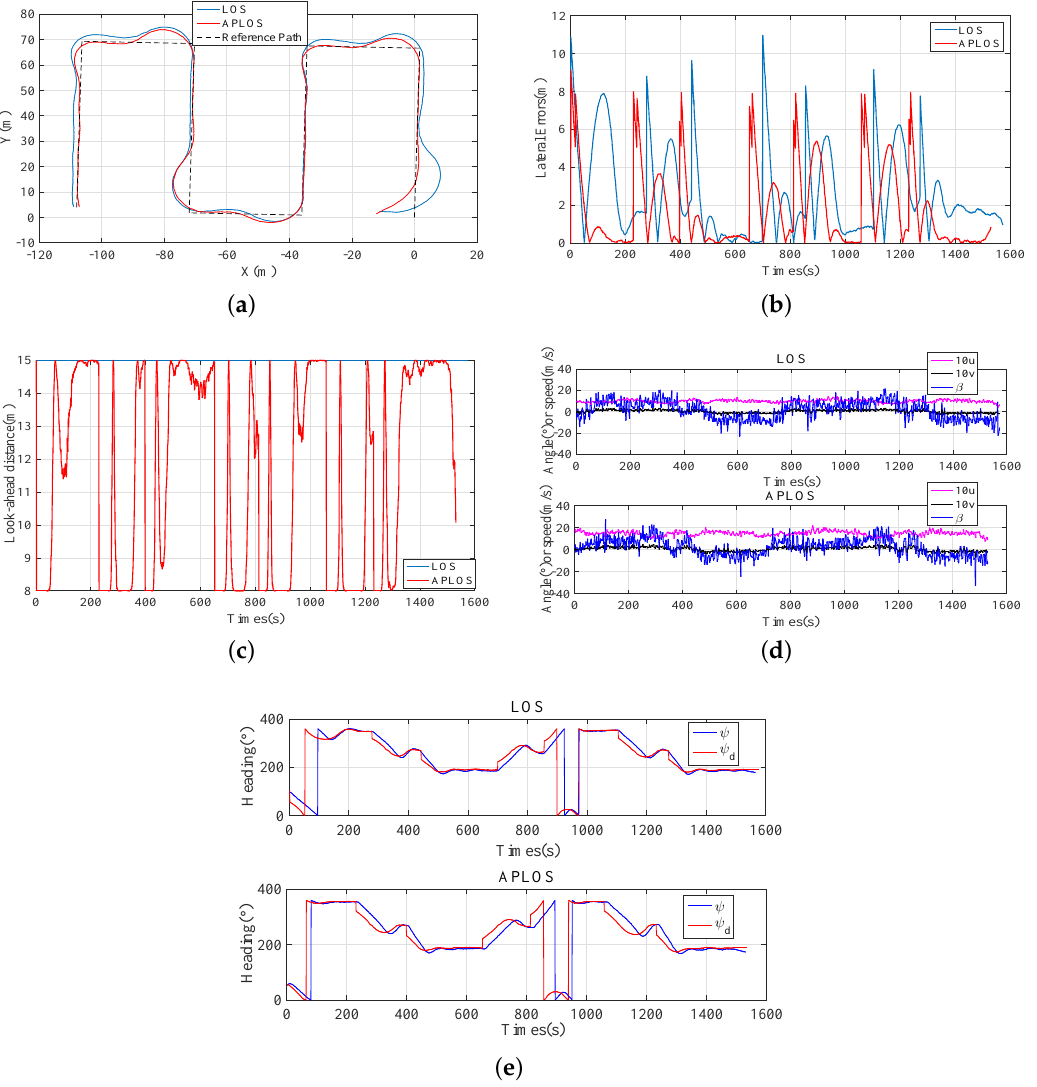
Figure 18. Lawnmower path following ( u = 1.5 m/s). ( a ) comparison of trajectory; ( b ) comparison of cross-track error; ( c ) comparison of look-ahead distance; ( d ) comparison of velocity and drift angle; ( e ) comparison of heading